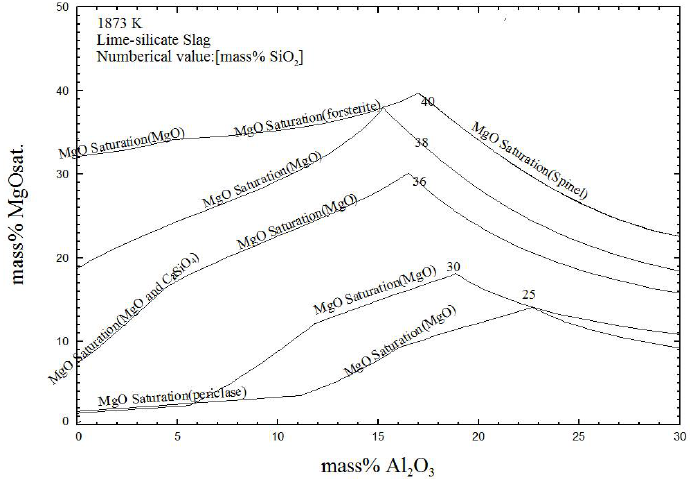
Figure 10. Effect of the Al 2 O 3 content on MgO solubility in lime-silicate slag at 1873 K.